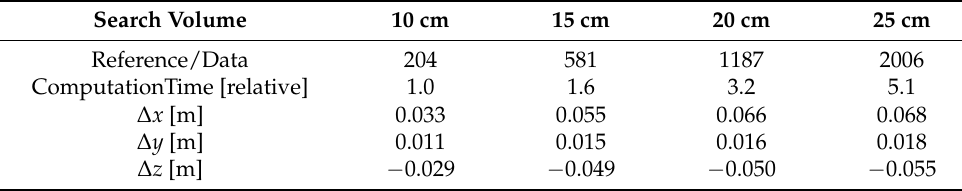
Table 1. Dependency of optimized solution based on search volume.